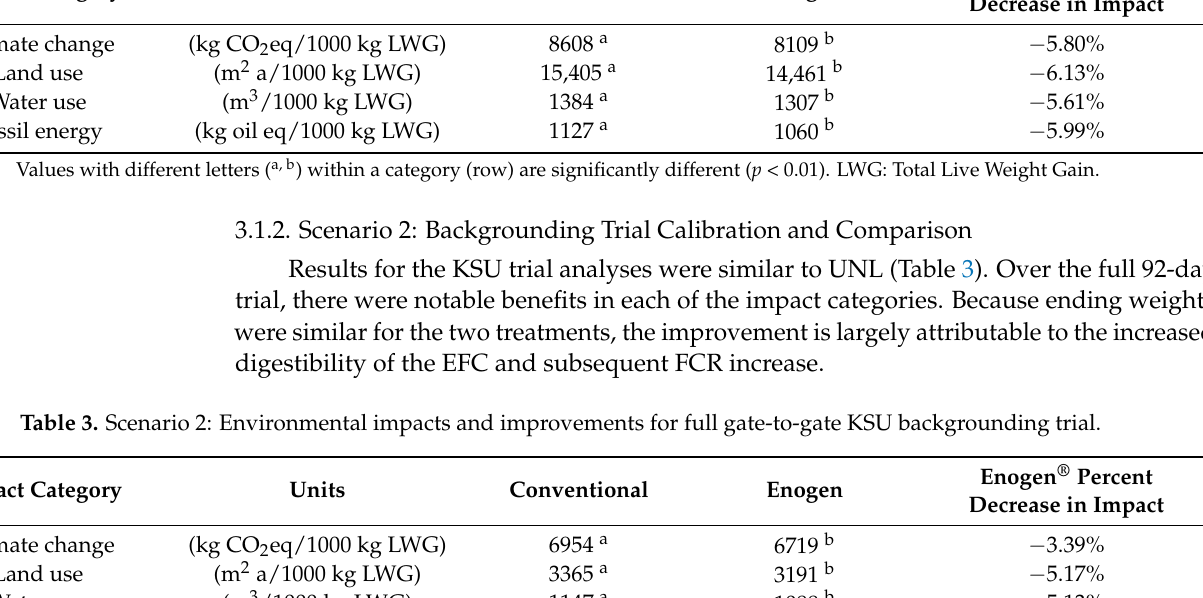
Table 2. Scenario 1: Environmental impacts and improvements for full gate-to-gate UNL feed yard trial. Impact Category